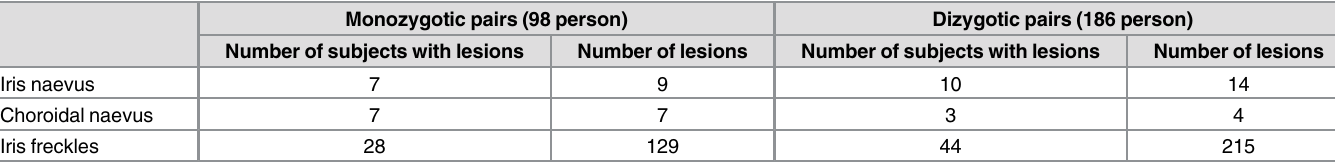
Table 4. Prevalence of benign pigmented ocular lesions among monozygotic and dizygotic twin pairs. Monozygotic pairs (98